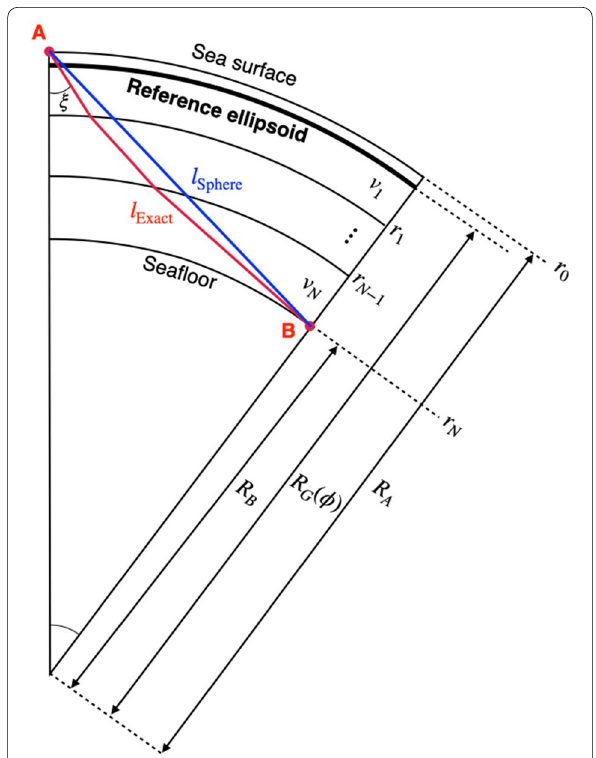
Fig. 1 Conceptional image of the acoustic path in this study. A horizontally stratified sound speed structure was assumed. Meanings of the characters are shown in the main